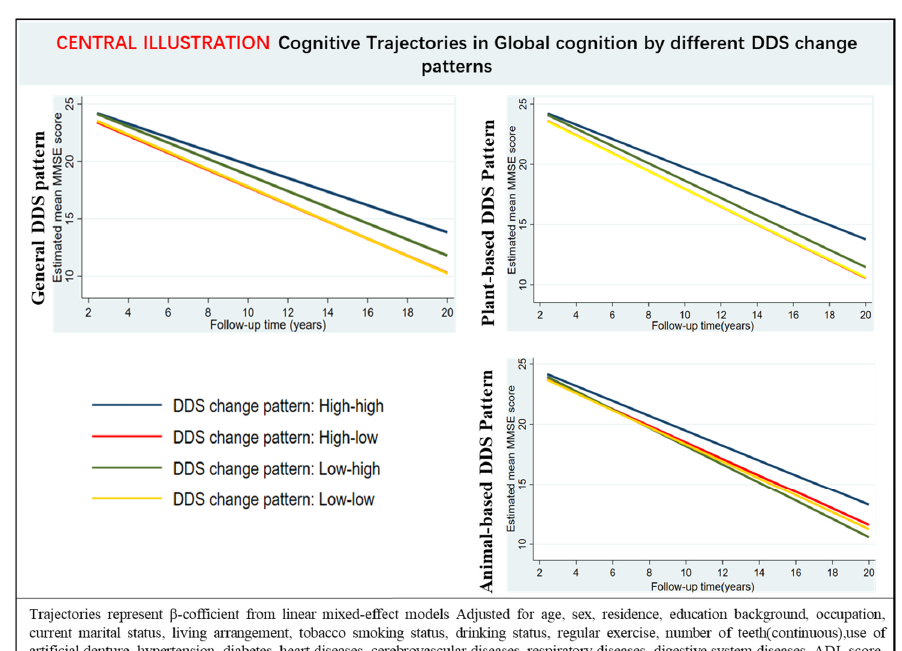
Figure 1. Estimated mean score of the mini-mental state examination with 95% CIs at follow-up year intervals among participants with different DDS change patterns.